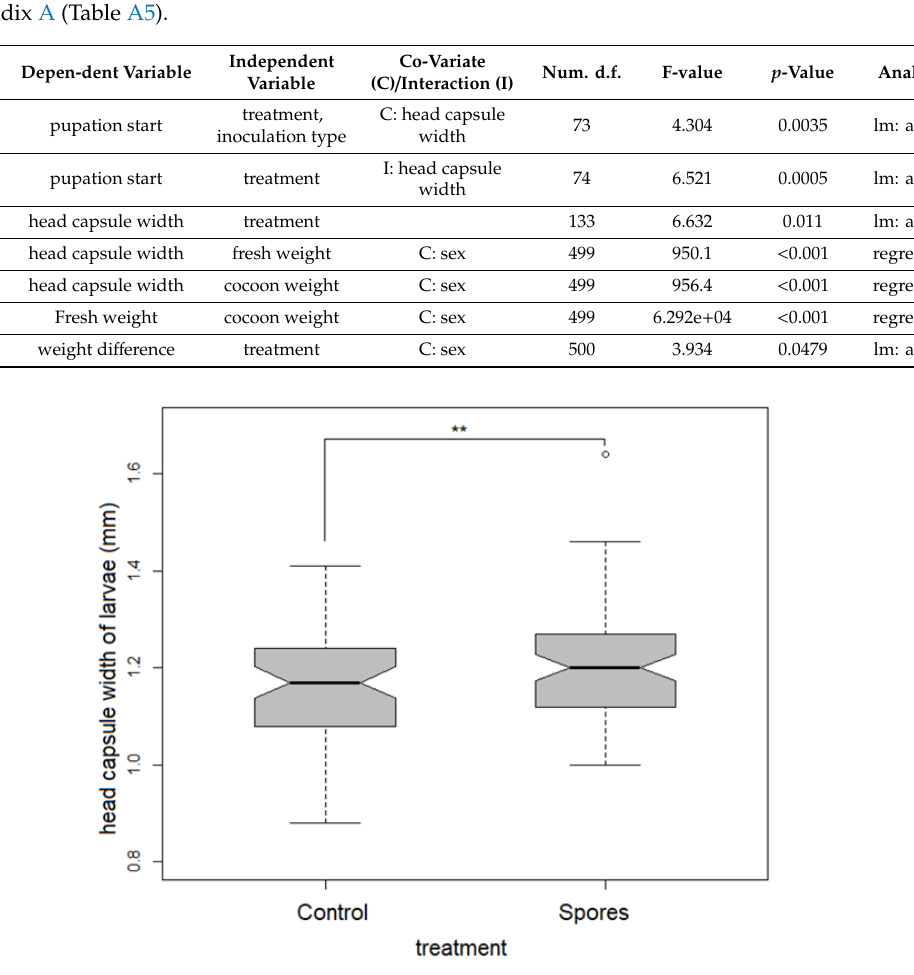
Table 2. Results of a linear multi-factorial model exploring the e ff ect of treatment (viable vs. sterile spores) on the pupation start, head capsule width, and weight di ff erences during development and results of regressions of the three datasets for two development stages. Head capsule width, bee age, or sex were used as covariates (C). lm = linear model. A table with estimates can be found in the